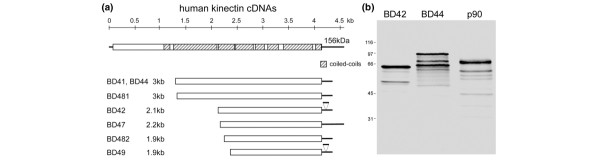
cDNA clones obtained from expression library screen using a BD serum. (a) Schematic diagram of the six overlapping cDNAs aligned with published human full-length kinectin sequence (4,816 bp, GenBank accession number NM_182926, shown on top). The open box represents the coding region of the full-length kinectin protein of ~156 kDa. cDNA inserts from the six independent clones BD41/BD44, BD481, BD42, BD47, BD482 and BD49 represent N-terminal truncations and are predicted as coiled-coil domains (hatched). ▽ represents short sequences derived from alternative mRNA splicing in the 3'-untranslated region. (b) Autoradiography of in vitro transcription and translation products of the candidate clones BD44 and BD42 labeled by [35S]-methionine and analyzed on a 12.5% gel SDS-PAGE. Products of BD44 and BD42 gave major bands with the highest molecular mass of 95 kDa and 60 kDa, respectively. The lane marked as p90 represents an unrelated autoantigen used as a positive control for the in vitro translation reaction. Molecular markers are shown on the left. BD, Behçet's disease.